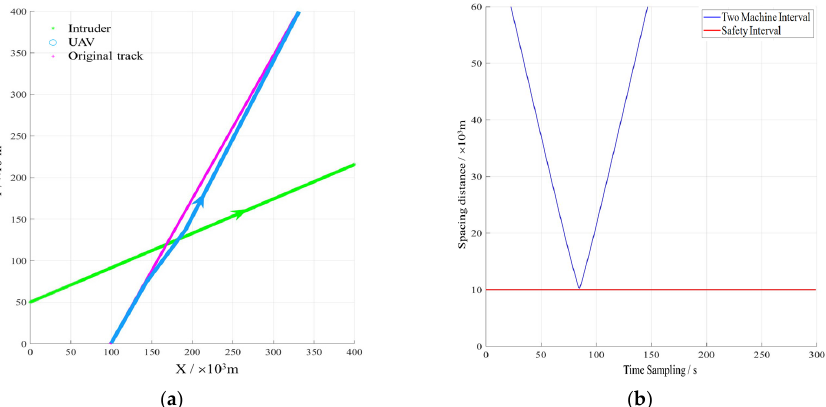
Figure 12. Compound relief scenario analysis: ( a ) compound deliverance scenario; ( b ) two-machine interval.